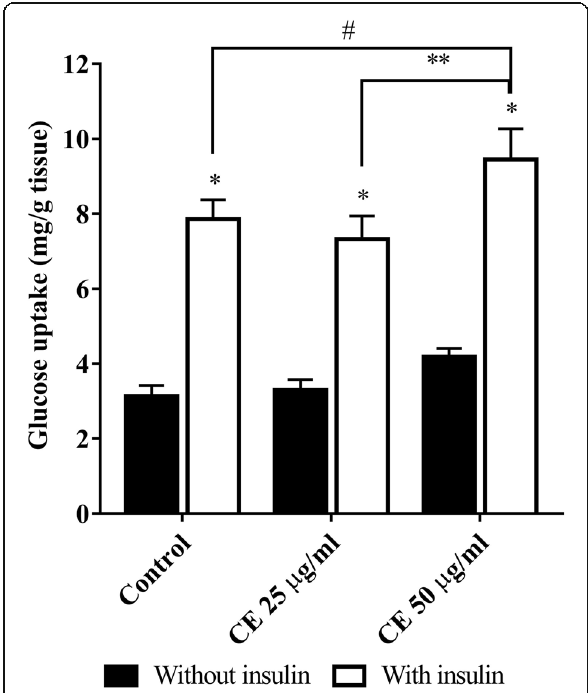
Fig. 5 The effect of C. cainito extract (CE) on glucose uptake by isolated mice abdominal muscle. The values are expressed as mean ± SEM, n = 5. * P < 0.05 compared with non-insulin in the same treated group, # P < 0.05 compared with control, ** P < 0.05 compared with CE 25 μ g/ml by two-way ANOVA followed by Student- Newman-Keuls as post hoc test